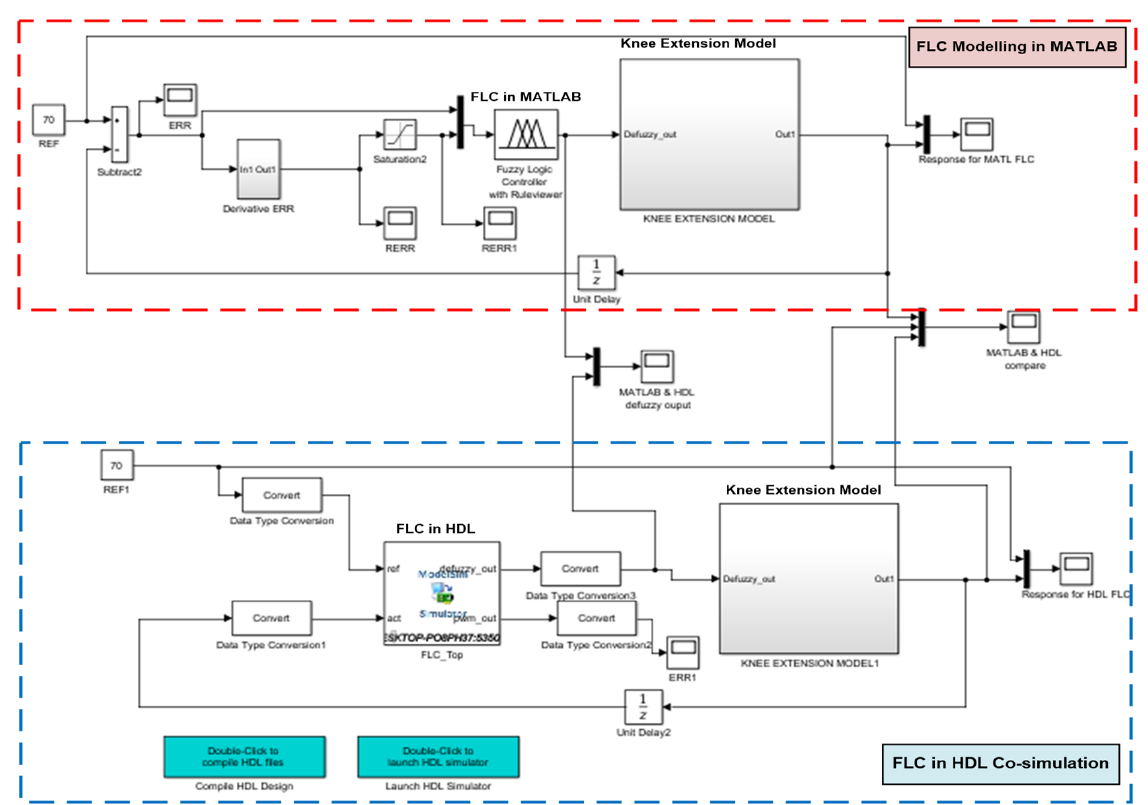
Figure 12. System level hardware description language (HDL) co-simulation development of FLC using the knee extension model as a plant in MATLAB Simulink.